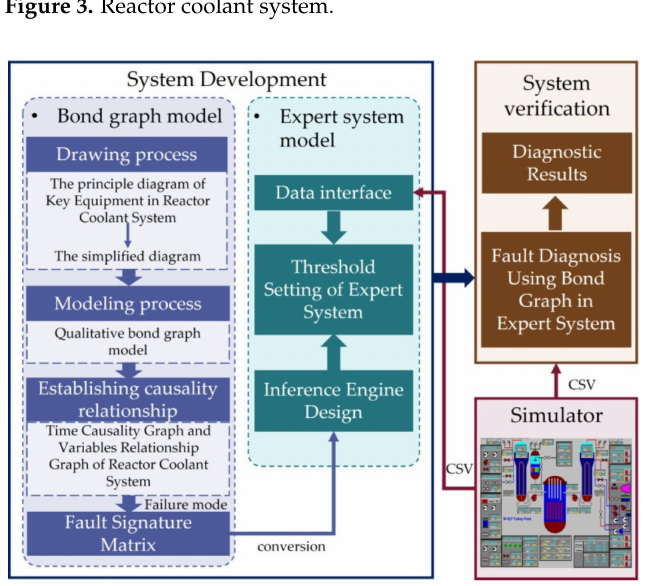
Figure 4. The proposed methodology structure